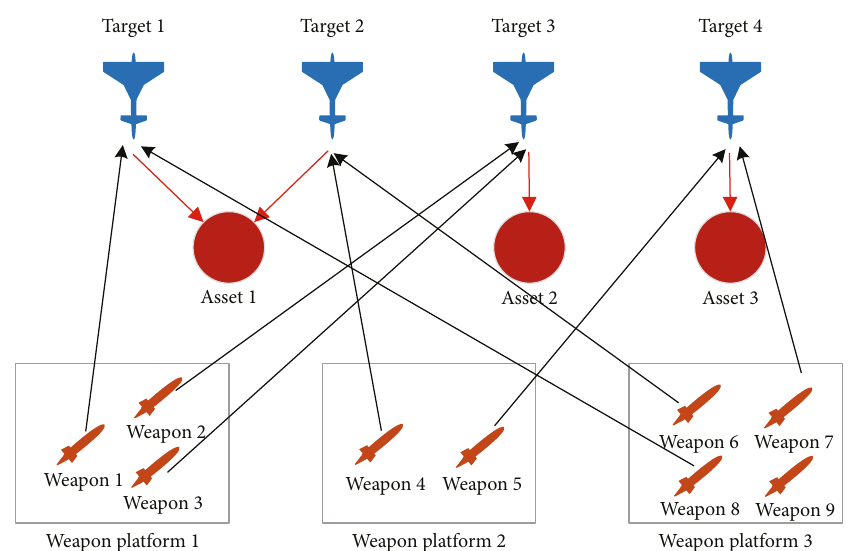
Figure 1: Illustration of asset-based SWTA